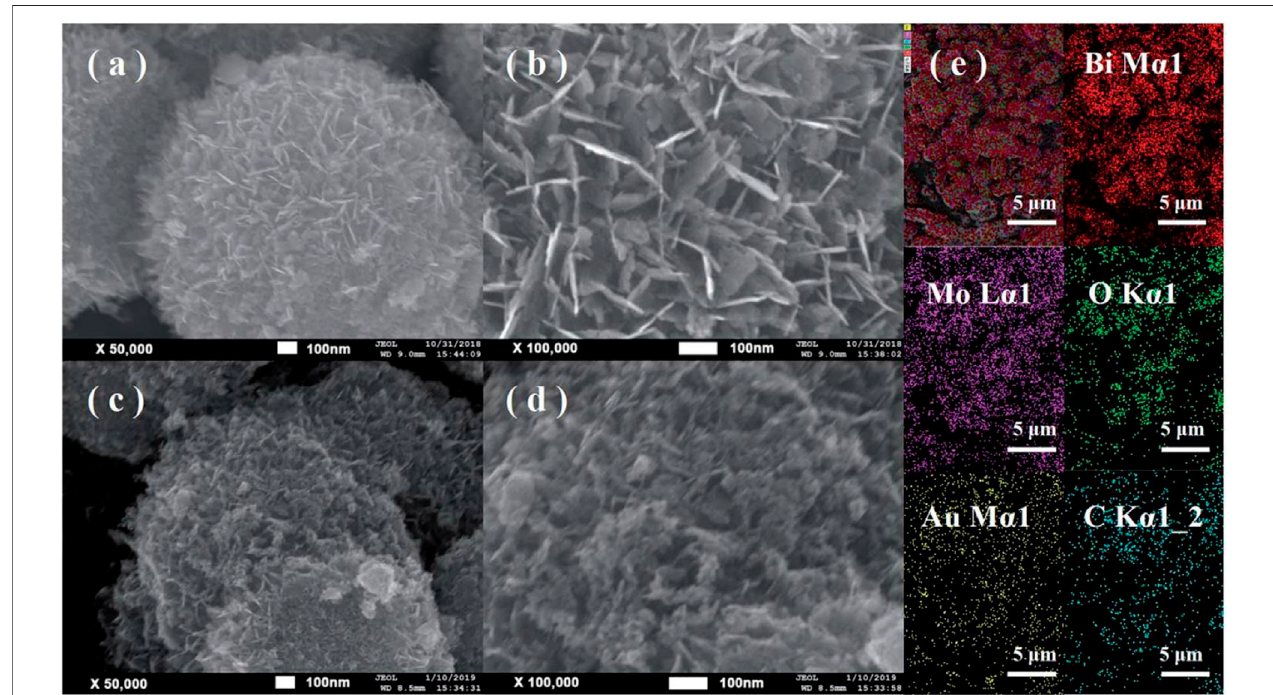
FIGURE10| FE-SEMimagesof (A,B) hollowBMOmicrosphereand (C,D) CQDs/Au/BMO; (E) EDXspectrumofsampleCQDs/Au/BMOshowingthepresenceof Bi, Mo, O, Au and C elements. (Reproduced from Zhao et al., 2021, Royal Society of